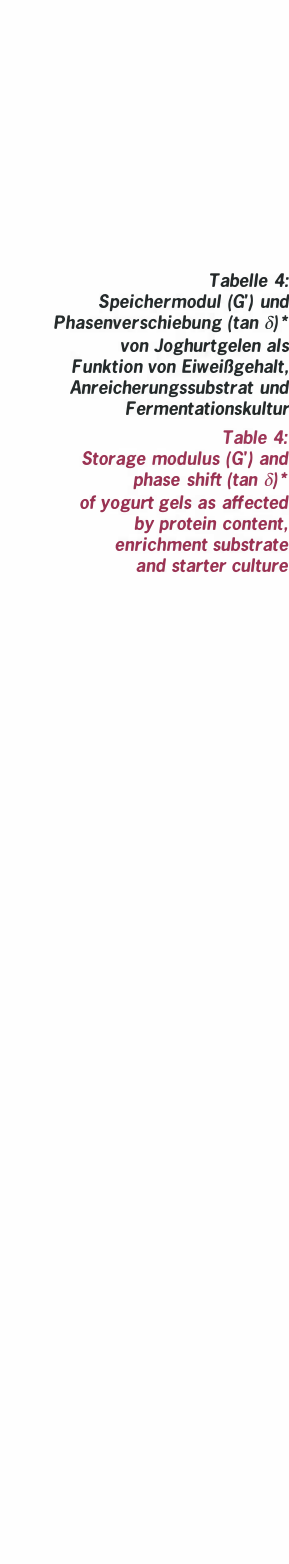
Fig. 3: Relation between storage modulus and casein content of yogurt